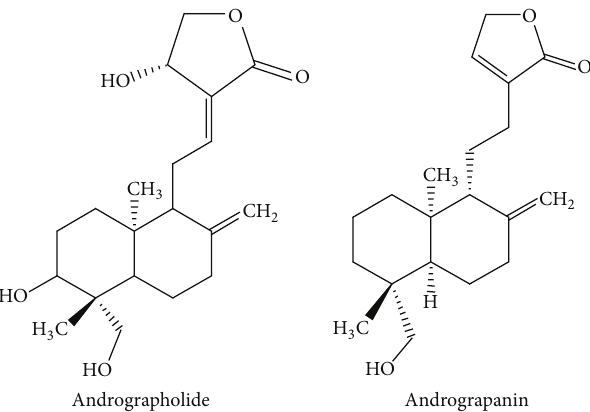
Figure 3: Chemical structures of Andrographis paniculata